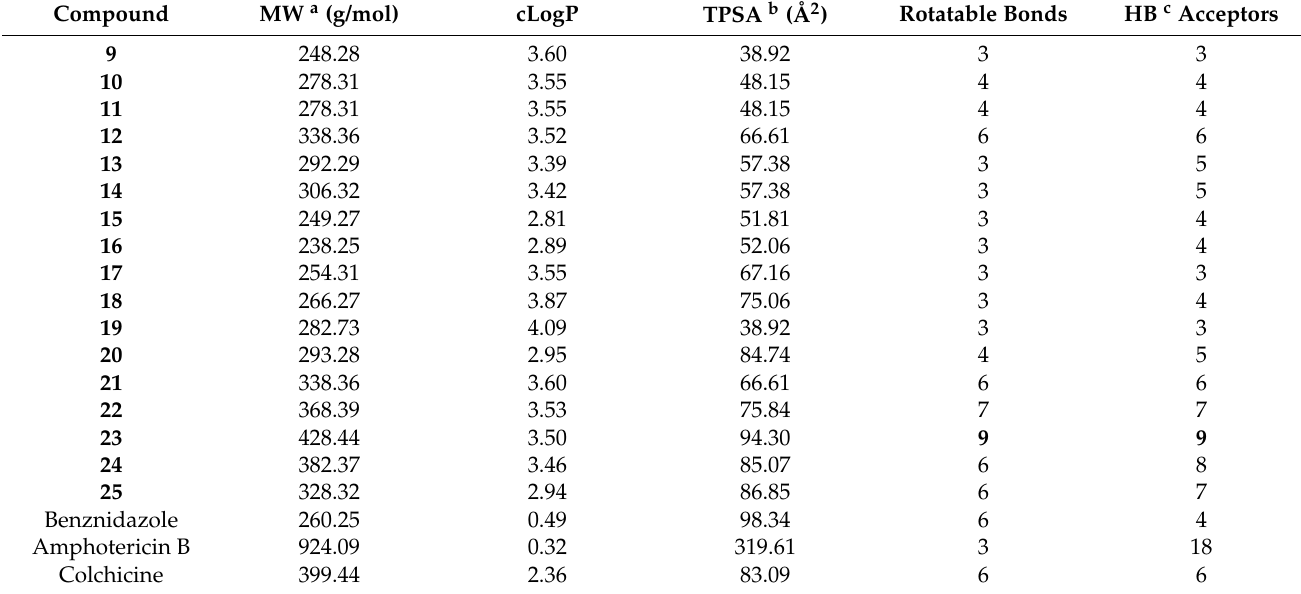
a Molecular weight. b Topological polar surface area. c Hydrogen